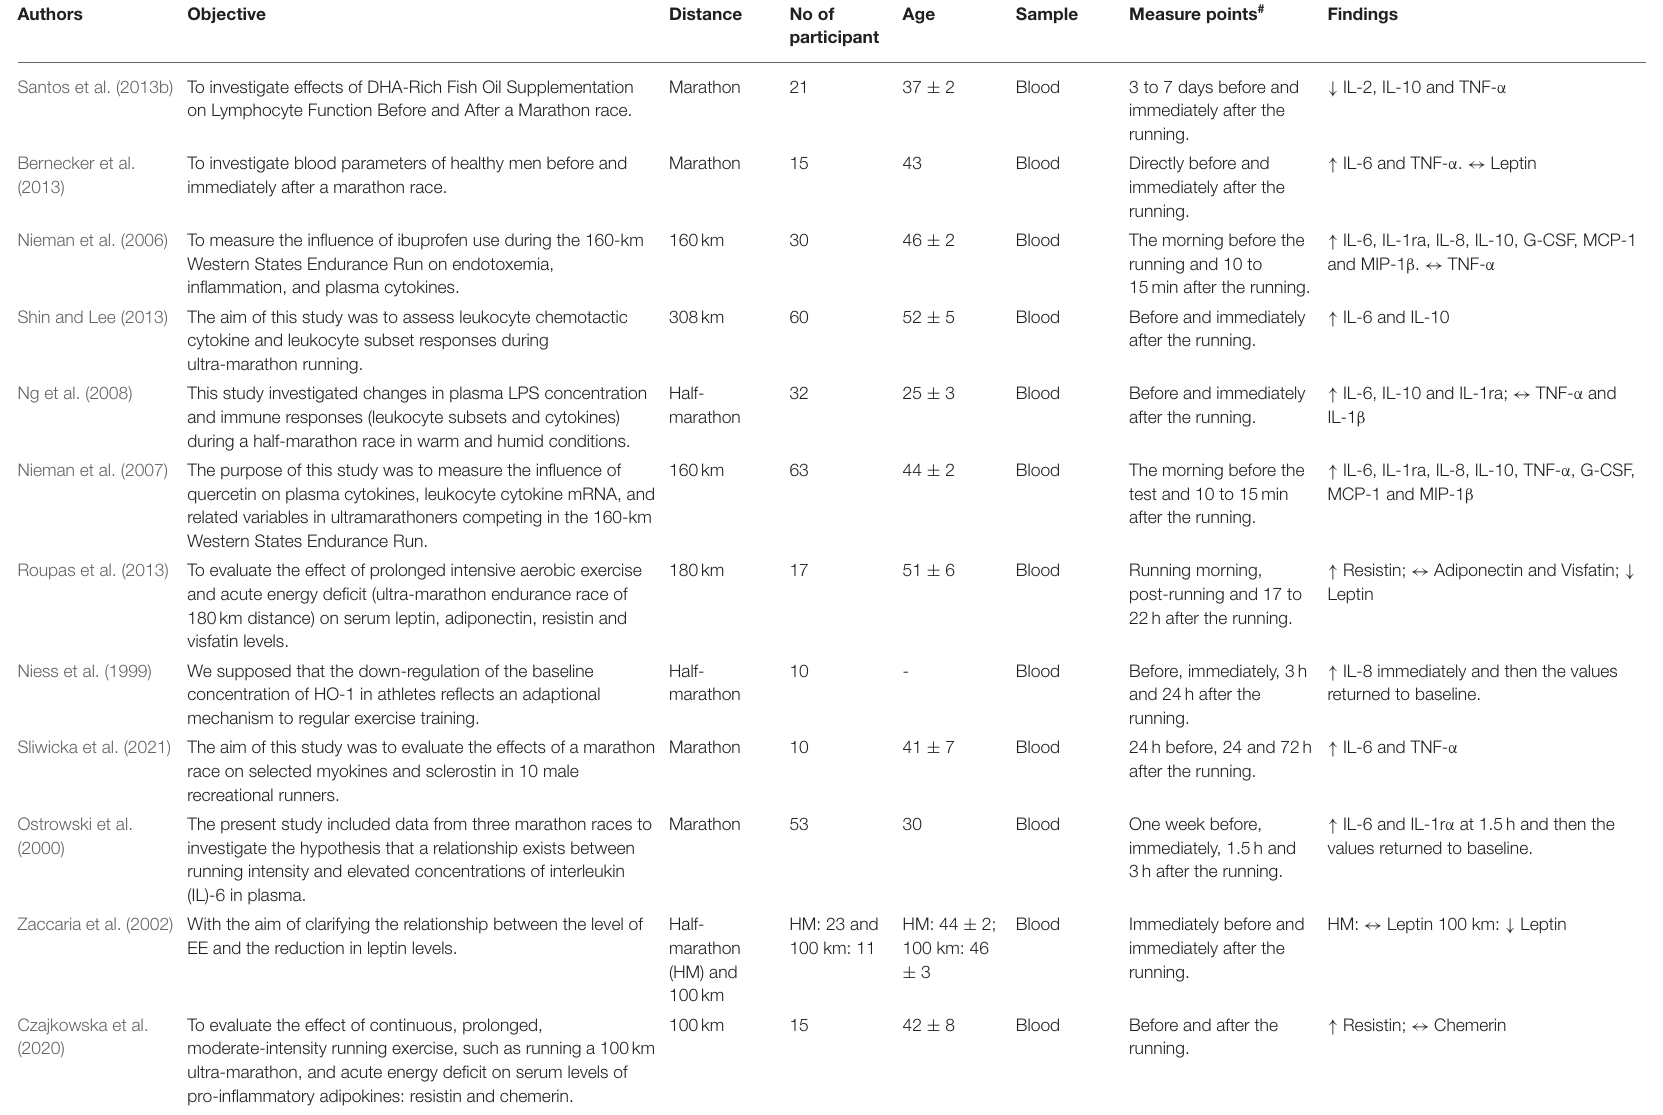
TABLE 2 | The study characteristics of included studies.